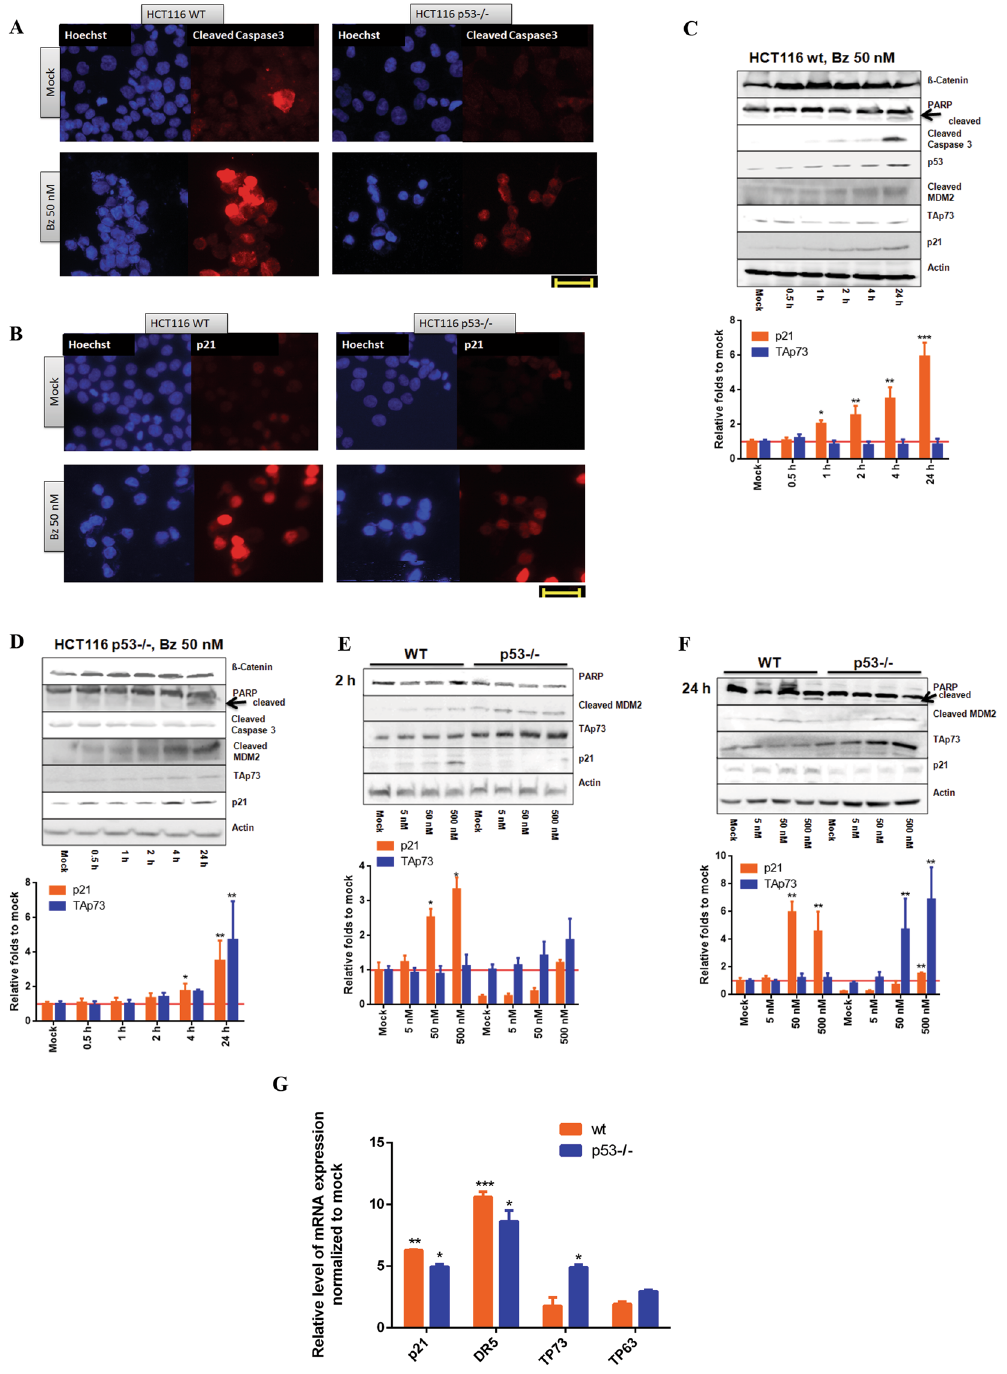
Figure 2. Similar cellular responses to bortezomib in HCT116 wt and p53 − / − cells within 24 hrs. ( A ) Bortezomib induced cleavage of Caspase 3 in HCT116 wt and p53 − / − cells. After treatment with bortezomib (50 nM) for 24 hrs, immunocytochemistry was employed to compare the presence of cleaved Caspase3 by using specific antibody. Hoechst dye was used to indicate nuclei. Scale bar: 40 µ m. DMSO (final concentration: 0.5%) was used as mock. ( B ) Bortezomib activated p21 in HCT116 wt and p53 − / − cells. Scale bar: 40 µ m. DMSO 0.5% was used as mock. ( C ) Study of time-dependent cellular responses analyzed by immunoblotting in HCT116 wt cells and ( D ) in HCT116 p53 − / − cells. The whole cell lysate was subjected to immunoblotting. Specific antibodies as indicated were used. ß-Actin served as loading control. ( E ) Concentration-dependent analysis upon treatment in HCT116 wt and p53 − / − cells after 2 hrs and ( F ) 24 hrs treatment with bortezomib. ( G ) qRT-PCR analysis on the expression of members of the p53 family and their downstream genes. Cells were treated with a concentration of 50 nM of bortezomib for 24 hrs. 0.5% DMSO was used as mock. Densitometric analyses were conducted by using Aida software (Raytest). * P < 0.05; ** p < 0.01 and *** p <